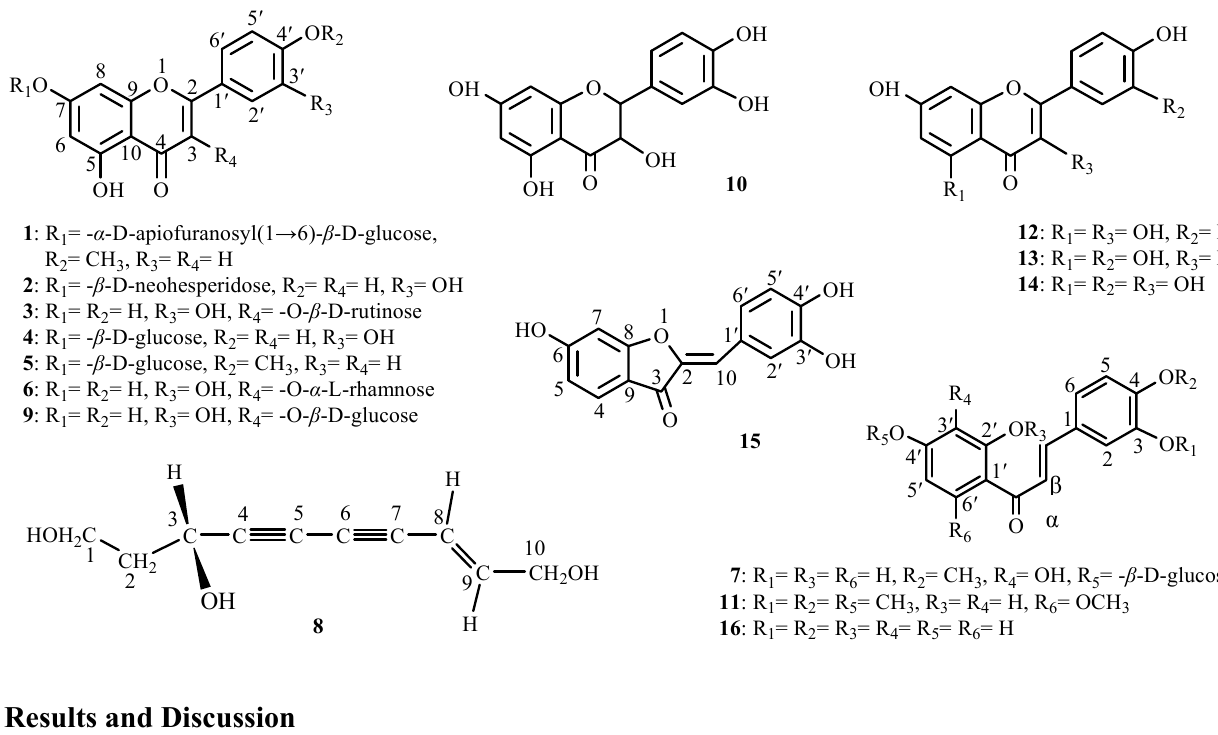
Figure 1. The structures of compounds 1 - 16